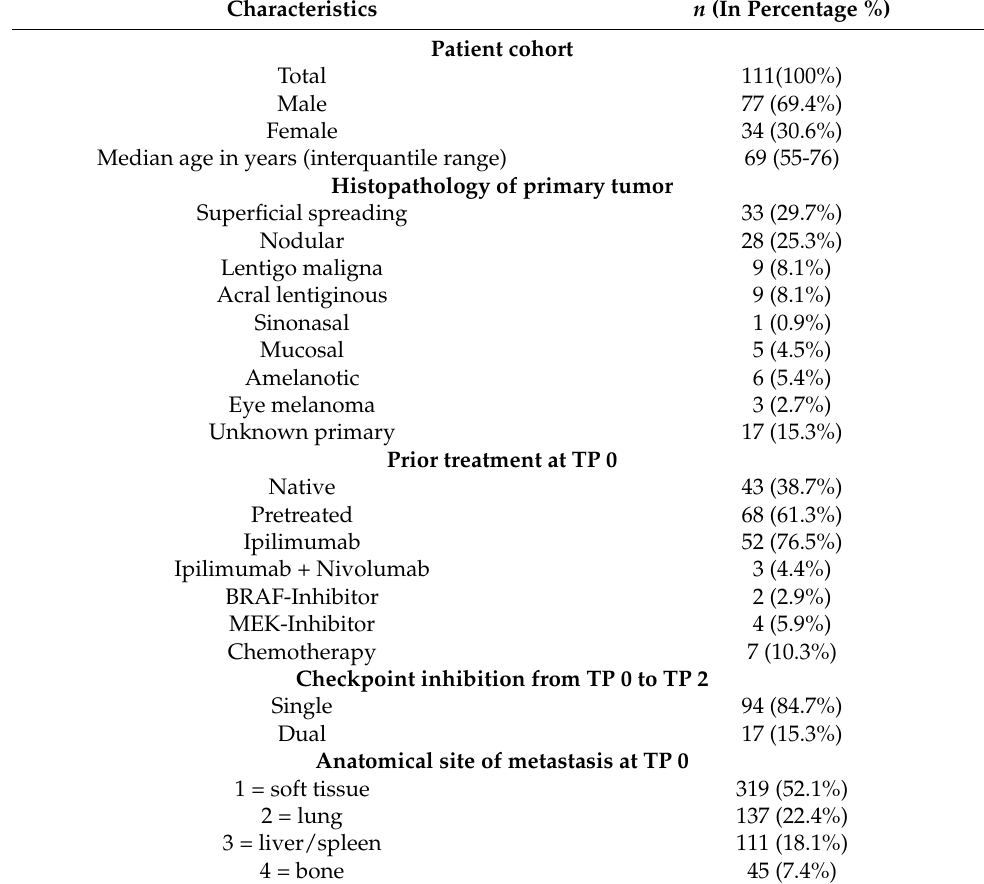
Table 1. Baseline characteristics of all included metastatic melanoma patients including gender, median age, histopathology of primary tumor, prior treatment at TP 0, type of checkpoint inhibition from TP 0 to TP 2 and anatomical site of melanoma metastasis at TP